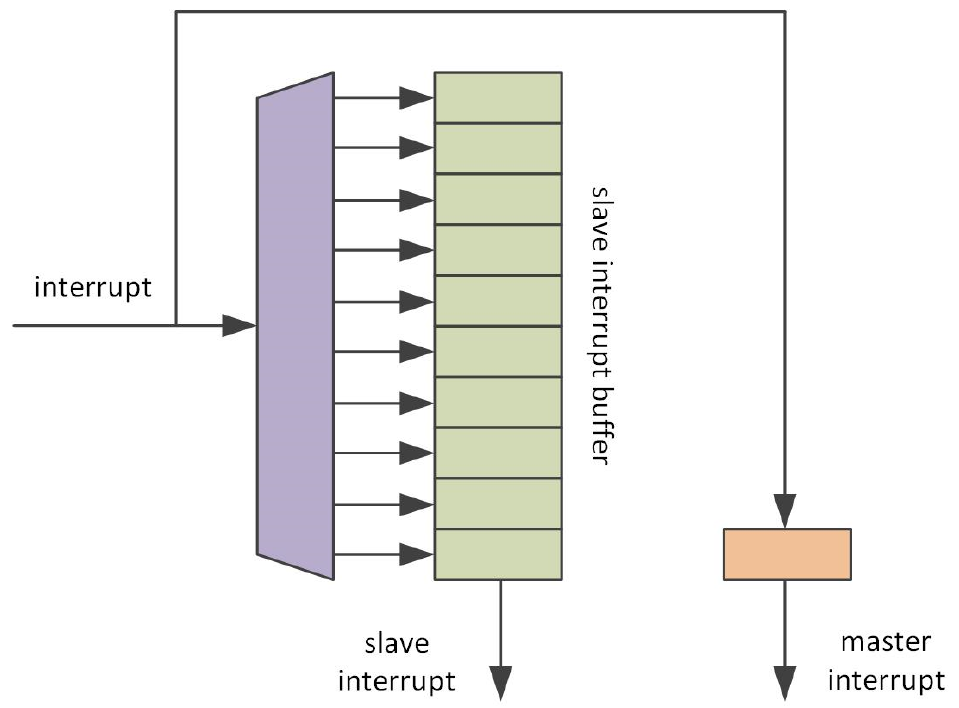
Figure 8. Block diagram of the VDCLS Interrupt Injection Module.